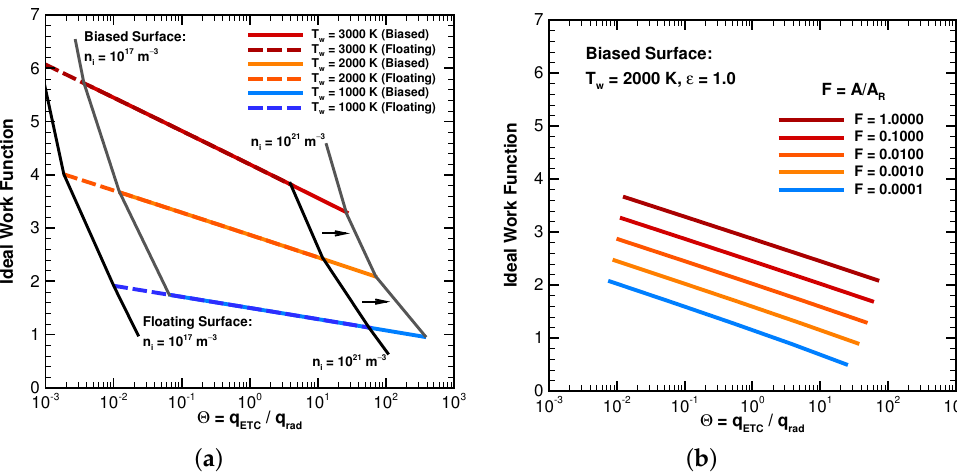
Figure 4. Ideal work functions based on Equations (28) and (29). All curves shown are plotted relative to a wall with (cid:101) = 1.0 and over the range of plasma densities, n i = 10 17 m − 3 − 10 21 m − 3 . ( a ) Compares floating and biased solutions for a range of wall temperatures with A = A R . ( b ) Shows the effect of A for a biased surface, at a constant wall temperature.